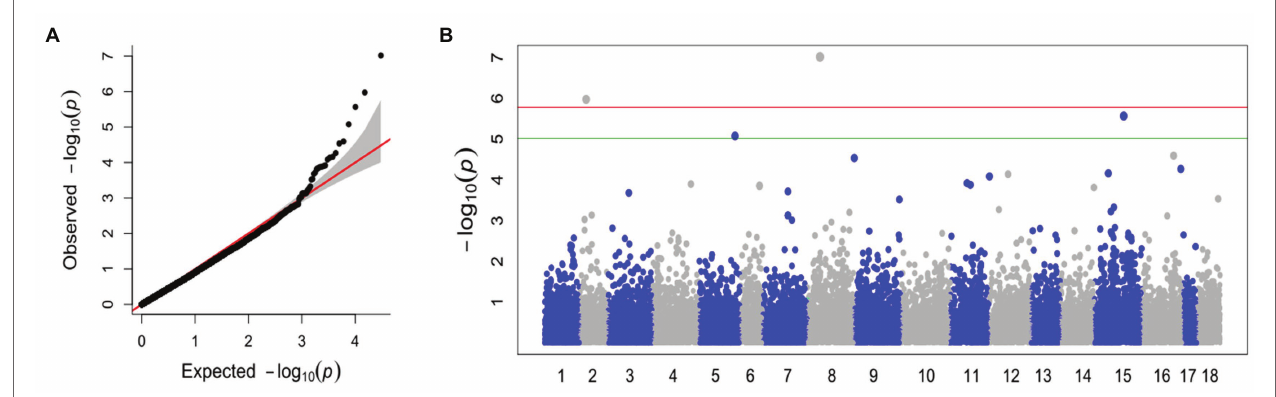
FIGURE 2 | (A) Quantile-quantile plot for the broad genomic association model (GWAS), with the inclusion of the first main component (PC1 and PC2) as a covariate. (B) Manhattan plot for the GWAS. The x axis shows the chromosomes containing the discovered markers in their respective positions. The y axis shows the log (value of p ) of the association. The green line represents the threshold obtained based on the data, and the red line represents the Bonferroni-corrected threshold of